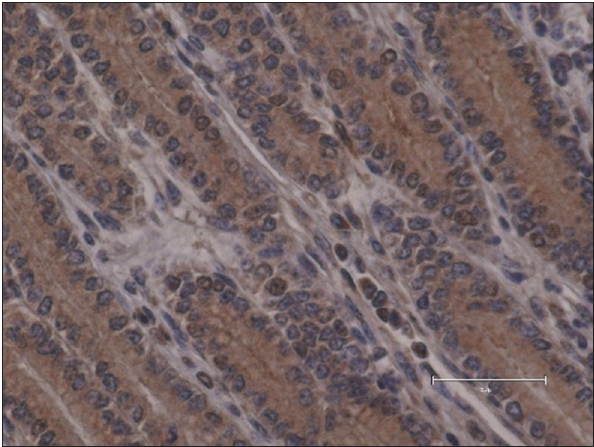
Figure-1: Abomasum pars pylorica in a 13-week-old calf from the control group – no ghrelin immunoreactive + cells observed (400×, DAB + hematoxylin, scale bar 50 µ m).